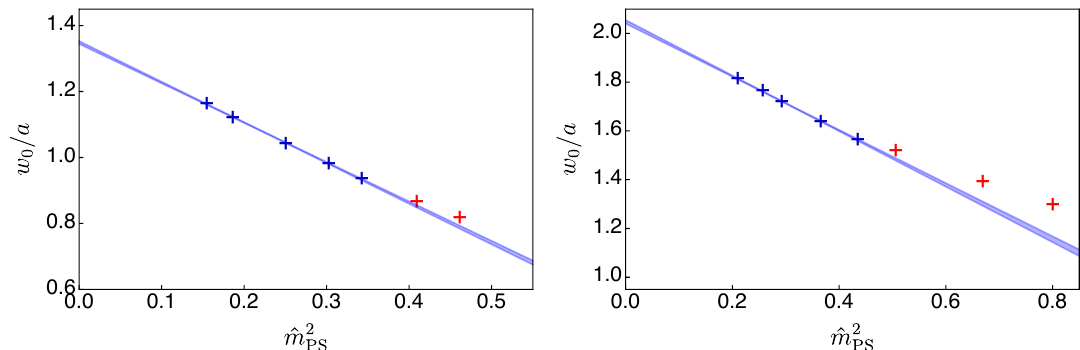
Figure 2. Gradient (cid:13)ow scale dependence on the pseudoscalar meson mass for (cid:12) = 6 : 9 (left panel) and (cid:12) = 7 : 2 (right panel). Numerical data from table 1 and from table 6. The blue bands as based upon eq. (3.8), with the (cid:12)t parameters in table 2. The band width represents the (1 (cid:27) ) statistical uncertainties. The (cid:12)ts are restricted to the (cid:12)ve ensembles with lightest PS mass (shown in blue), while larger ^ m 2 (shown in red) are not included. PS